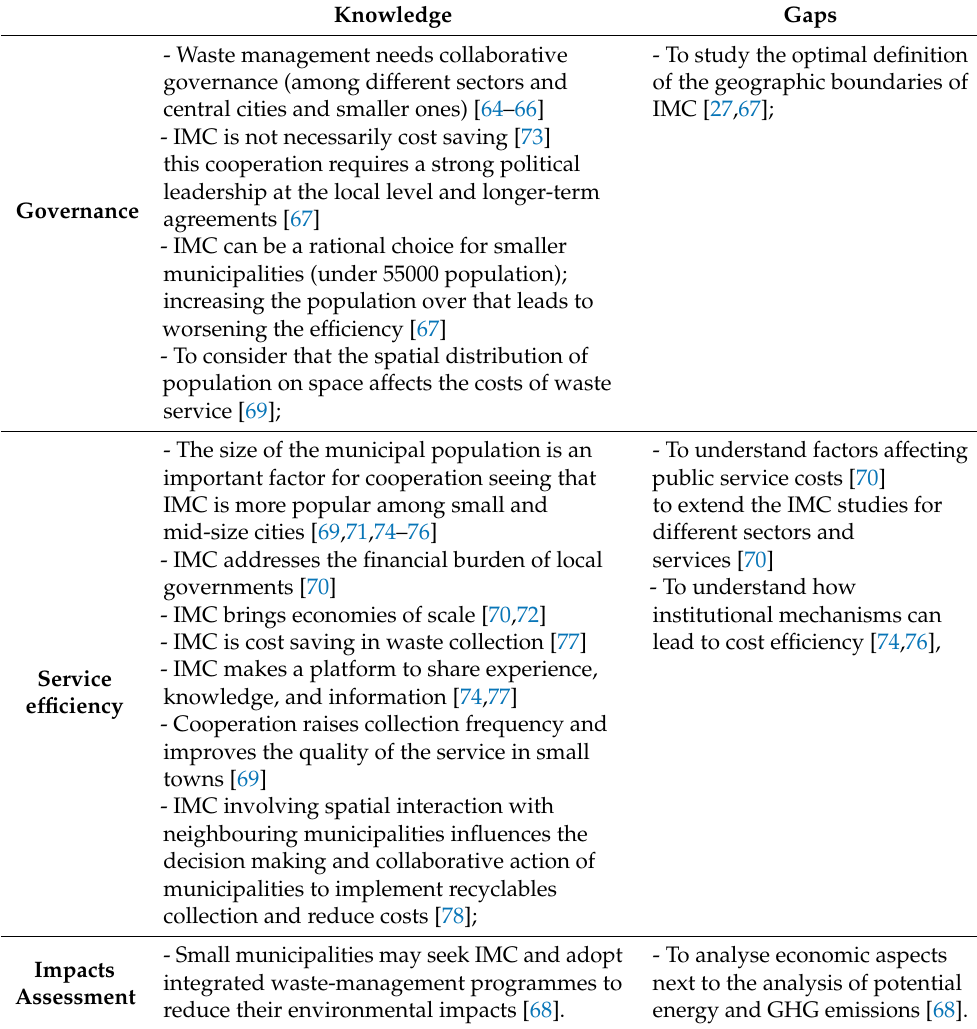
Table 5. Summary of emerging knowledge and the gaps on articles crossing IMC and